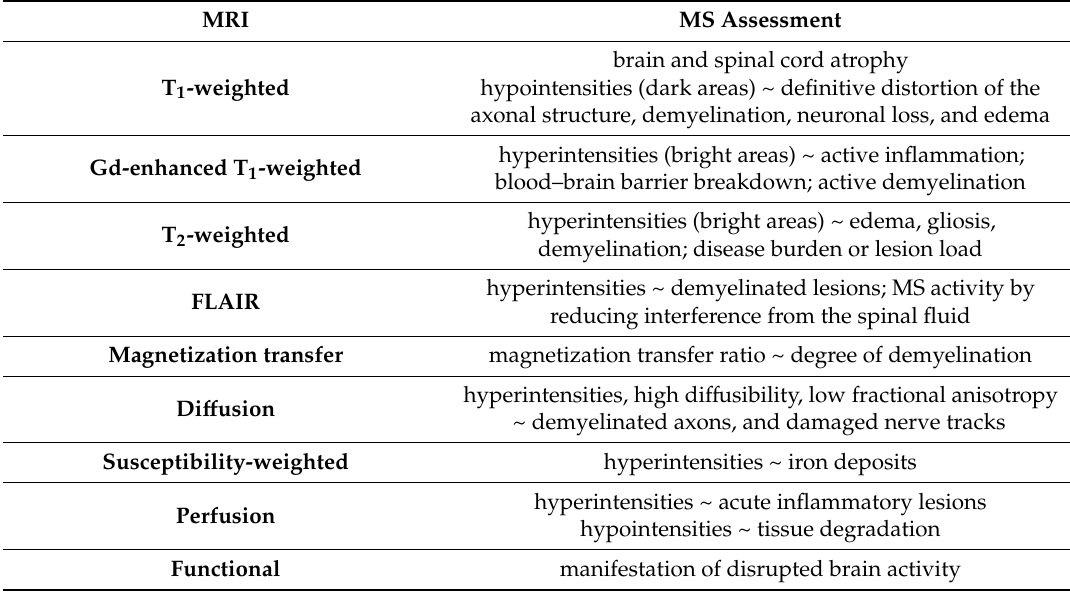
Table 1. Summary of general magnetic resonance imaging (MRI) diagnostic tools in multiple sclerosis (MS) assessment. Table summarizing general MRI diagnostic tools suitable for the assessment of MS with typical disease manifestations (marked with the symbol